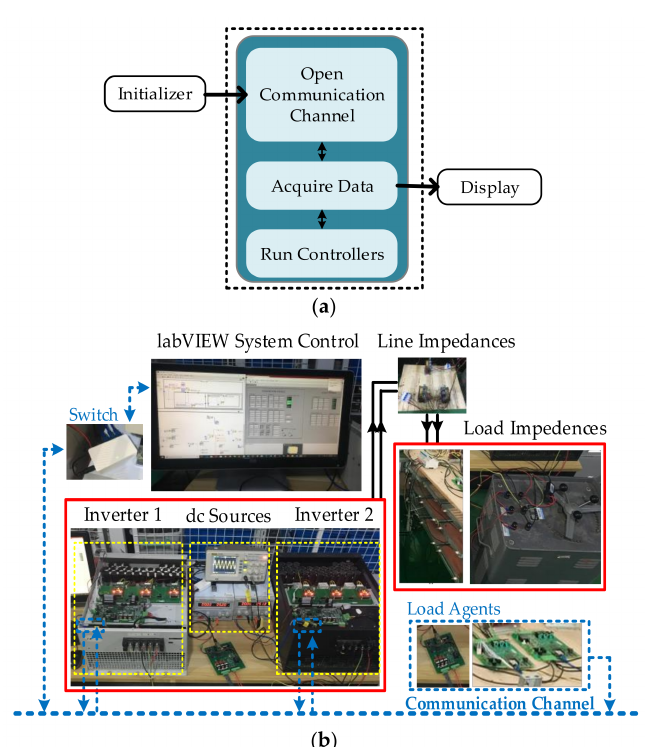
Figure 3. ( a ) General procedure of LabVIEW control system. ( b ) Laboratory experimental